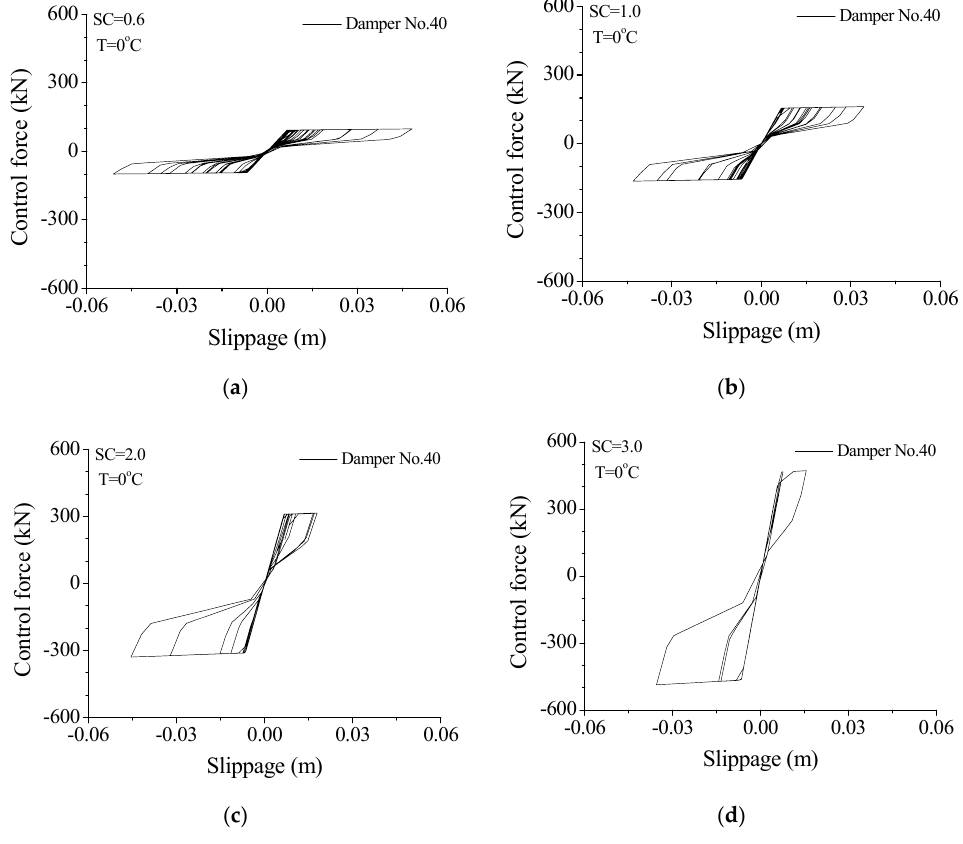
Figure 10. Variation of hysteresis loop with damper stiffness. ( a ) SC = 0.6; ( b ) SC = 1.0; ( c ) SC = 2.0; ( d ) SC = 3.0.